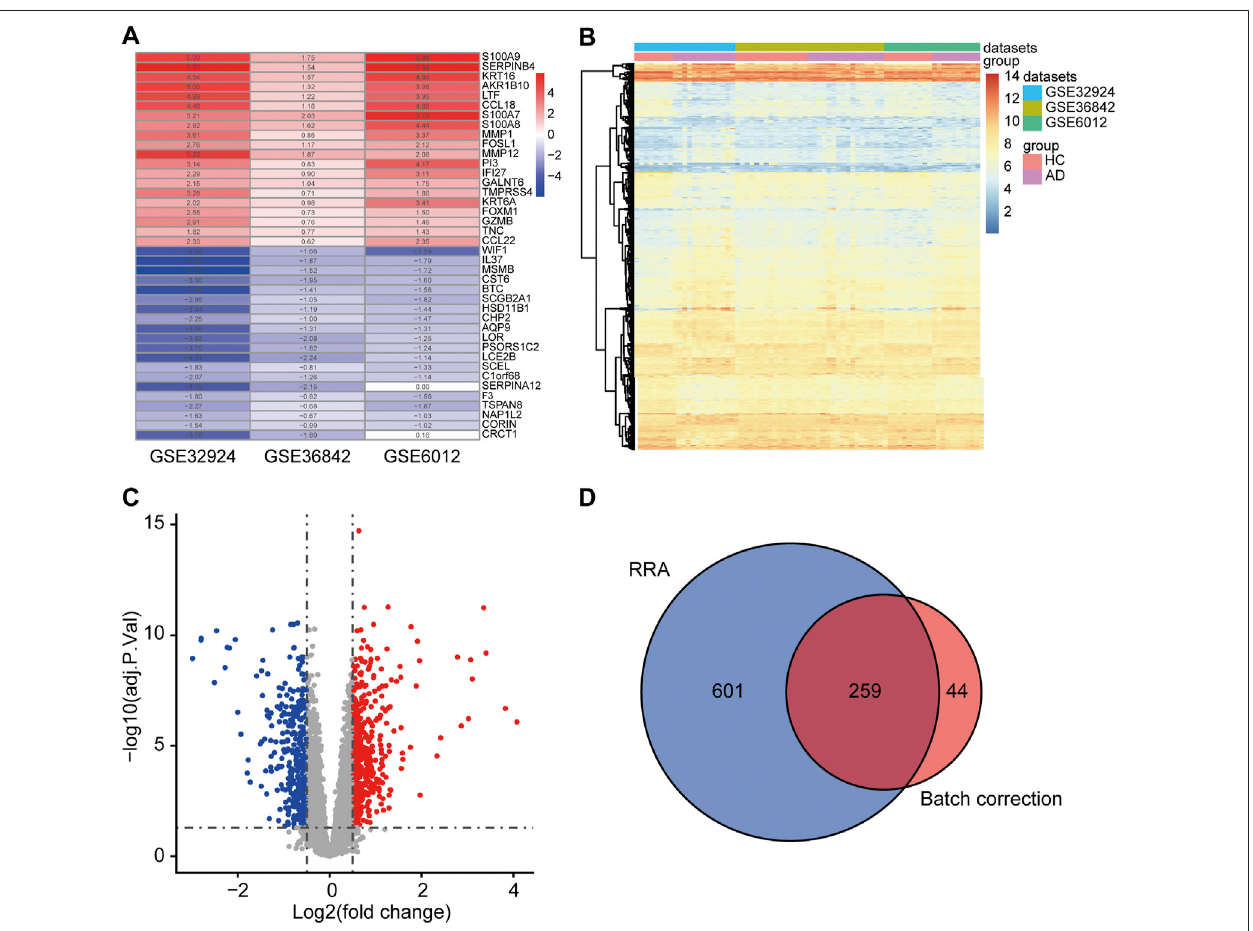
FIGURE2 | Determination of DEGs. (A) The fi rst 20 upregulated and downregulated DEGs ofthe three datasets merged using the “ RRA ” approach. (B) Heat map of the DEGs obtained via the “ Batch correction ” approach. (C) Volcano map of the DEGs obtained via the “ Batch correction ” approach. (D) Venn diagram of the intersection of the DEGs screened using the two methods. DEGs, differentially expressed genes; RRA, RobustRankAggreg.